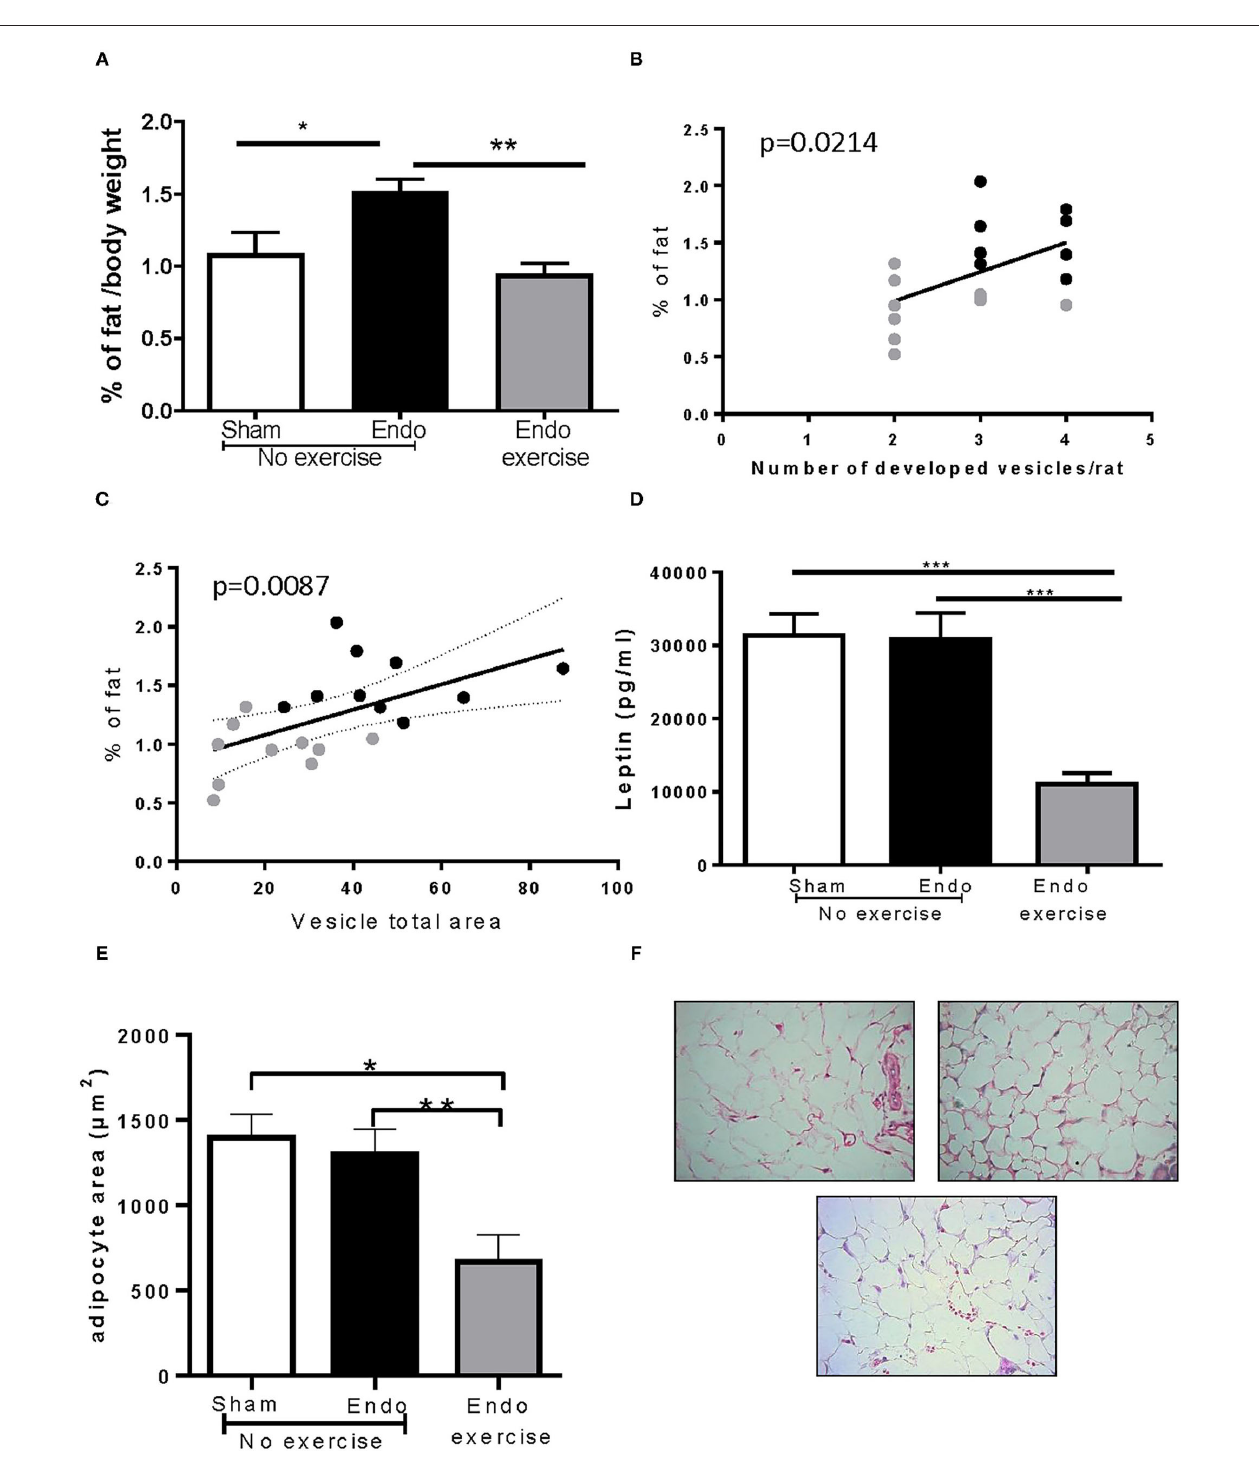
FIGURE 4 | Effect of exercise on body fat. (A) Endo-Exercise animals had significantly less mesenteric fat when compared to Endo-No exercise; (B) Animals with higher % of fat developed more vesicles; (C) Animals with a higher % of fat had vesicles with a larger total area. (D) Endo-Exercise animals had significantly less circulating leptin in serum and (E) significantly smaller adipocytes. (F) Representative photos of adipocytes in mesenteric fat from (left to right): Sham-No exercise, Endo-No exercise and (bottom) Endo-Exercise animals, × 40 magnification ( n = 9–10/group ± sem; * p < 0.05, ** p < 0.01, *** p < 0.001; n = 5–6/group ± sem for adipocytes; black circles represent Endo-No exercise, gray circles represent Endo-Exercise).